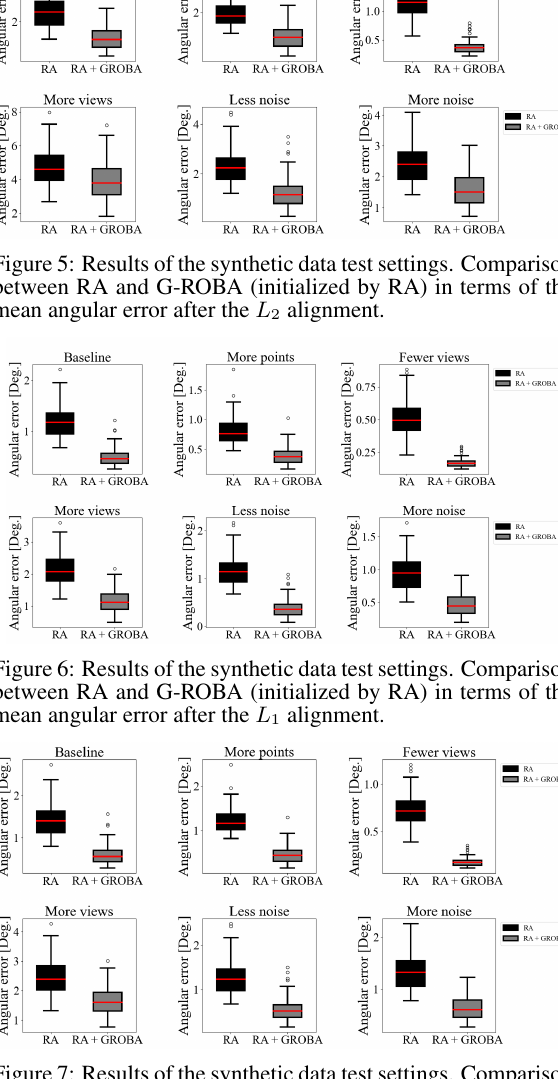
Figure 7: Results of the synthetic data test settings. Comparison between RA and G-ROBA (initialized by RA) in terms of the mean angular error after the L 2